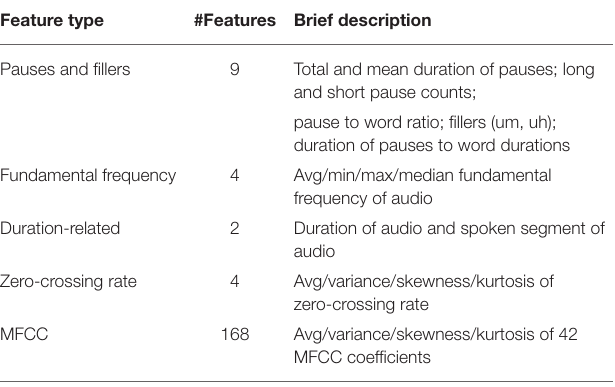
TABLE 5 | Summary of all acoustic/temporal features extracted.